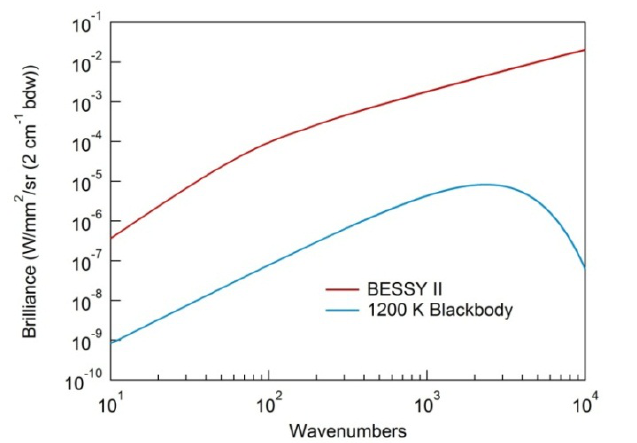
Figure 2: Calculated brilliance in the infrared spectral range for the IRIS beamline at BESSY II and for a globar